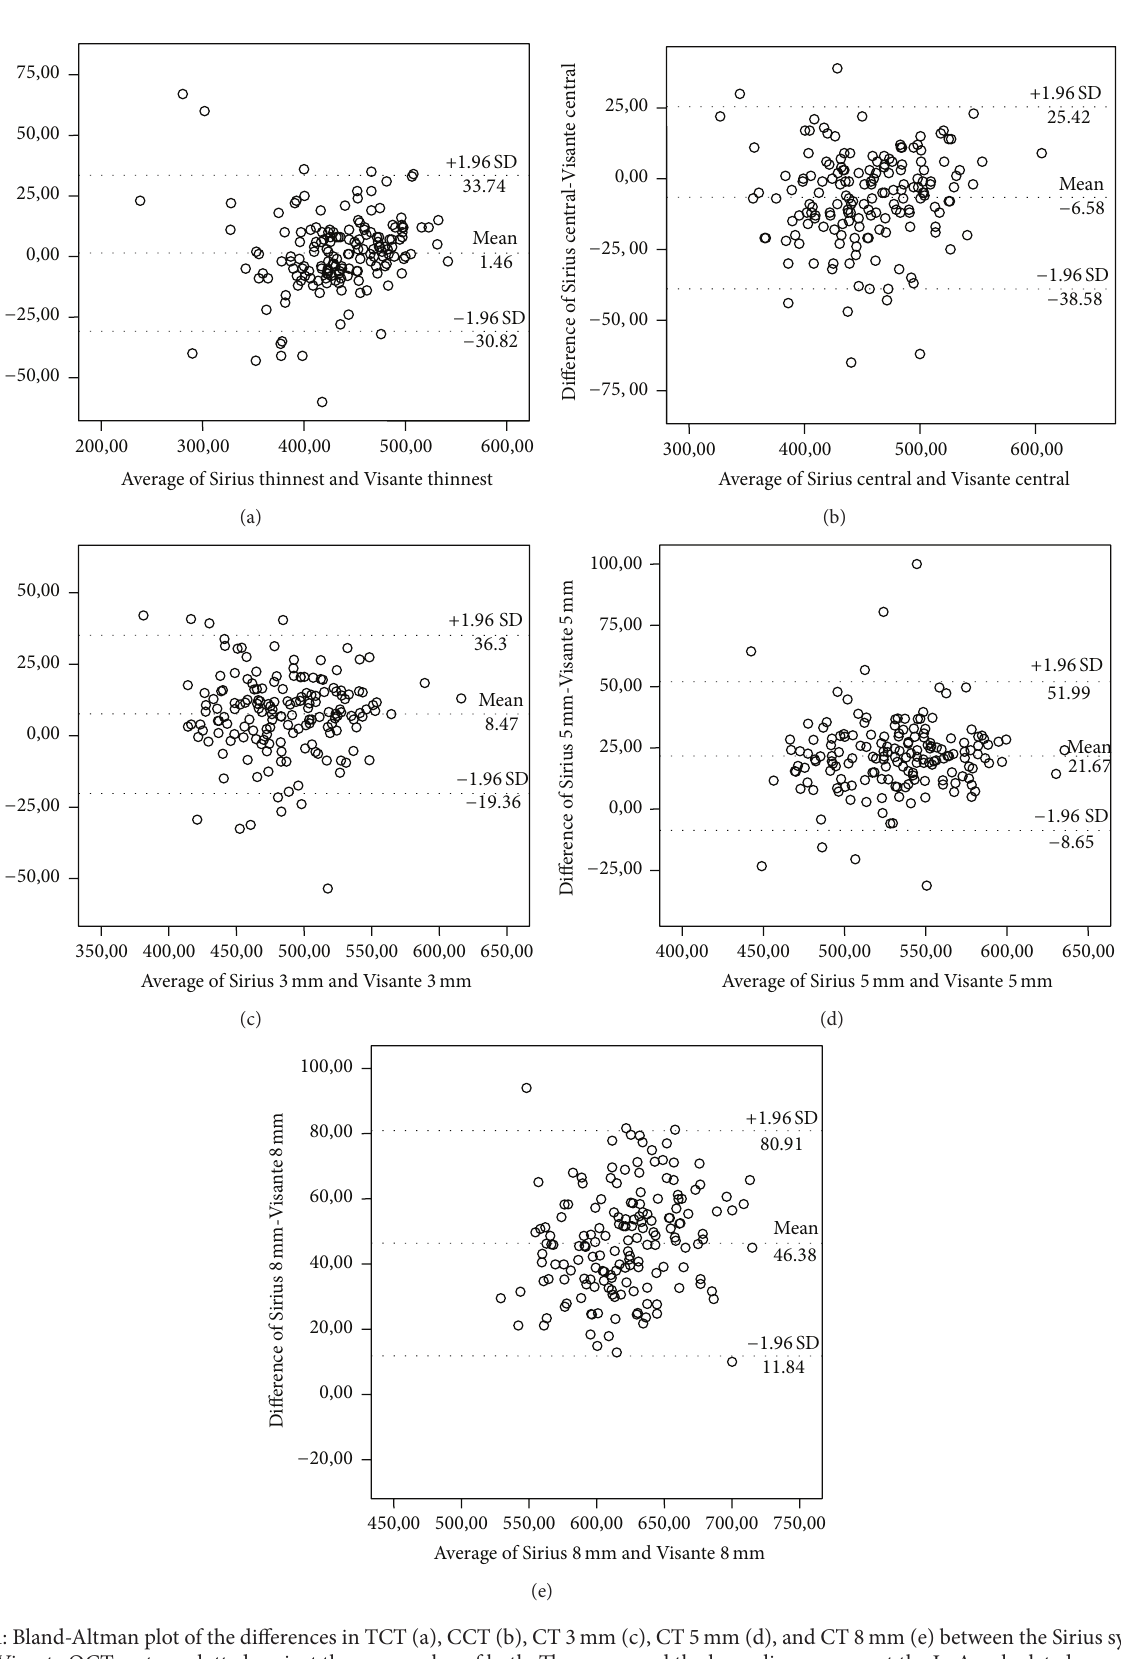
Figure 1: Bland-Altman plot of the differences in TCT (a), CCT (b), CT 3mm (c), CT 5 mm (d), and CT 8 mm (e) between the Sirius system and the Visante OCT system plotted against the mean value of both. The upper and the lower lines represent the LoA, calculated as mean ± 1.96